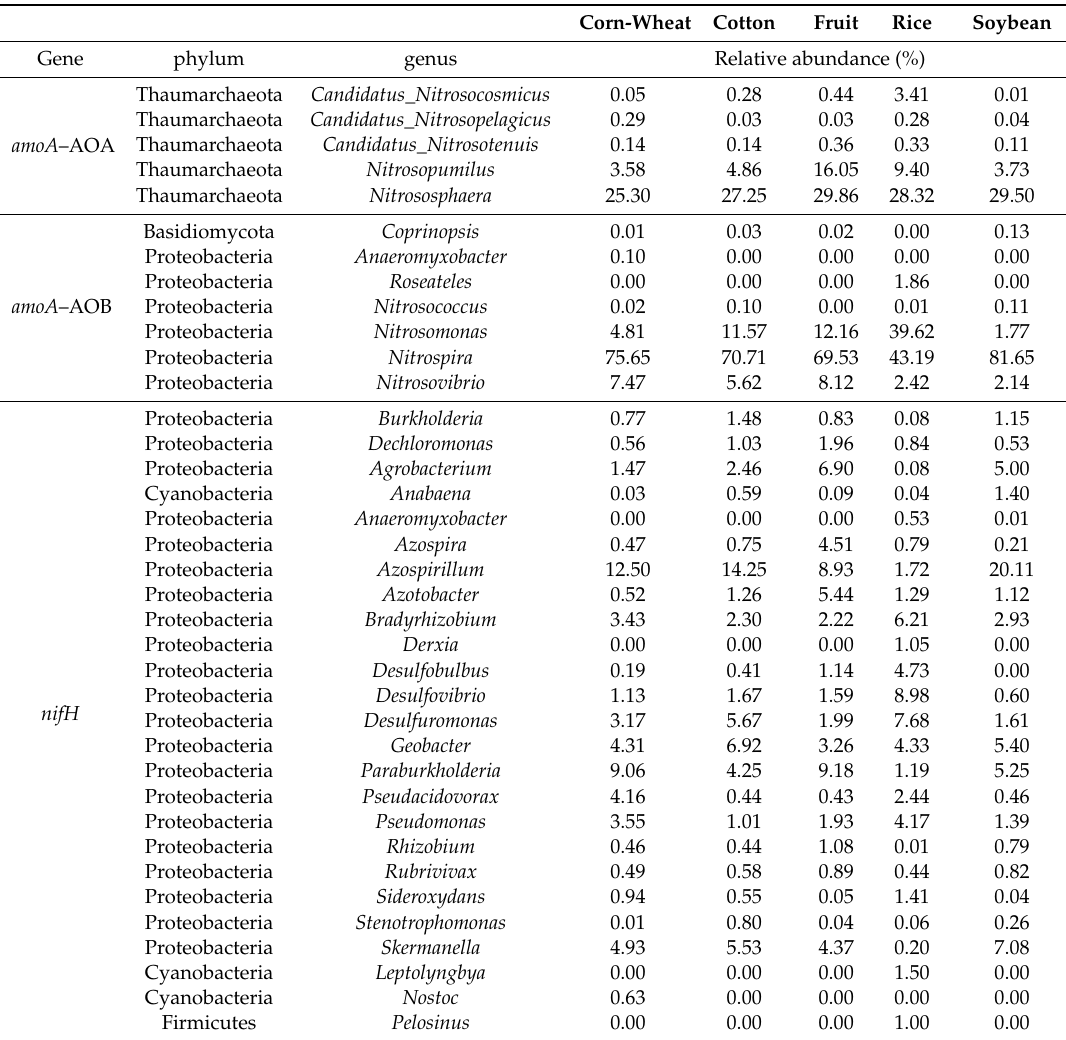
Table 5. The relative abundance of nitrogen functional genera from the five agroecosystems. The genus of AOA– amoA , AOB– amoA , nifH , nirK , and nirS with relative abundance > 0.01%, > 0.1%, > 0.5%, > 0.5%, > 0.5% at least in one agroecosystem were shown,